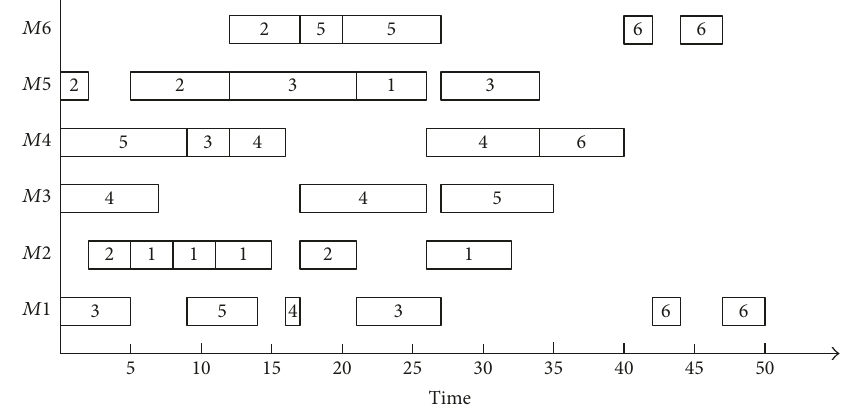
Figure 21: Scheduling Gantt chart for DE4 before optimizing.